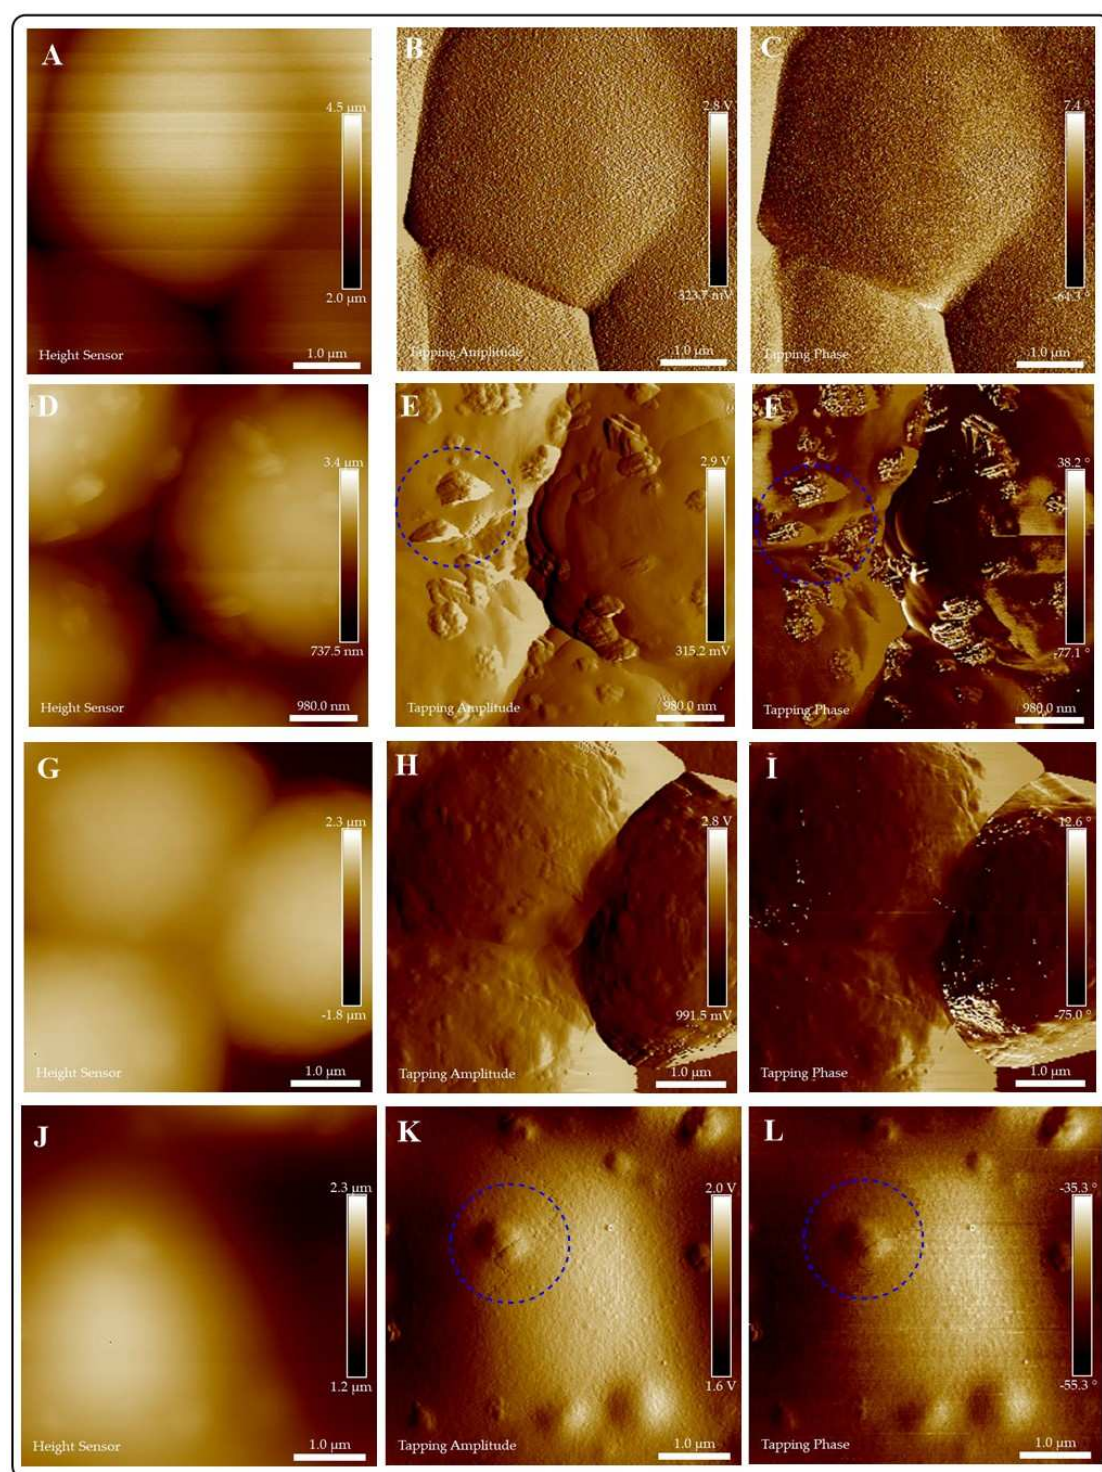
Figure 9. Evaluation of the exposition of C. albicans to different doses of CuI@Ch for 1 h. Height, amplitude and phase images are presented for: Control group ( A – C ), and C. albicans exposed to different doses of CuI@Ch: 75 µ g/mL ( D – F ); 100 µ g/mL ( G – I ); 125 µ g/mL ( J – L ). Blue dotted circles indicate the presence of aggregated NMs on the surface ( D – F ) or penetrating the cells ( G – L ). Figures E and F denote the presence of nanomaterials on the surface of the fungi. In particular, face change in F corroborates the presence of the nanomaterials on the surface. On the other hand, K and L illustrate the penetration of nanomaterials in fungal